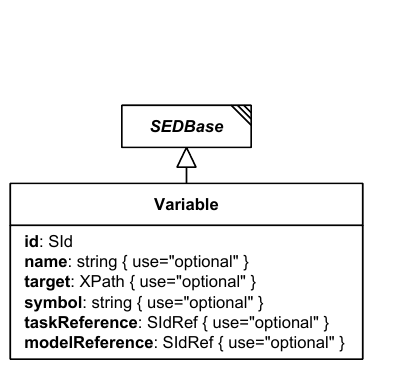
Figure 2.6: The Variable class